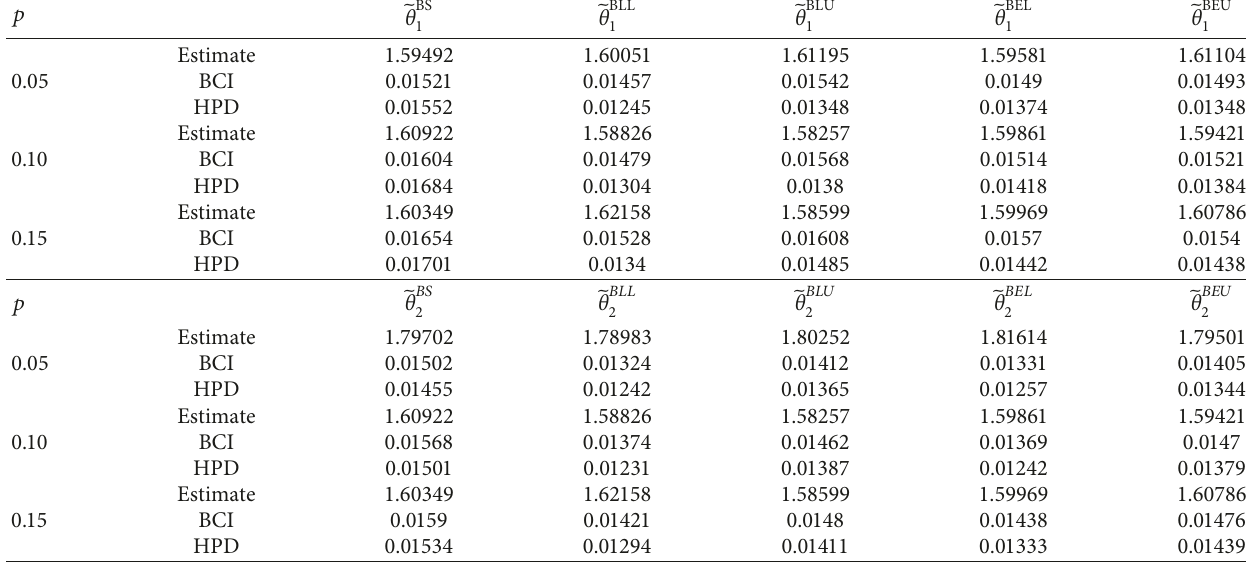
and θ with their lengths of CI for different m for n and p 1 2